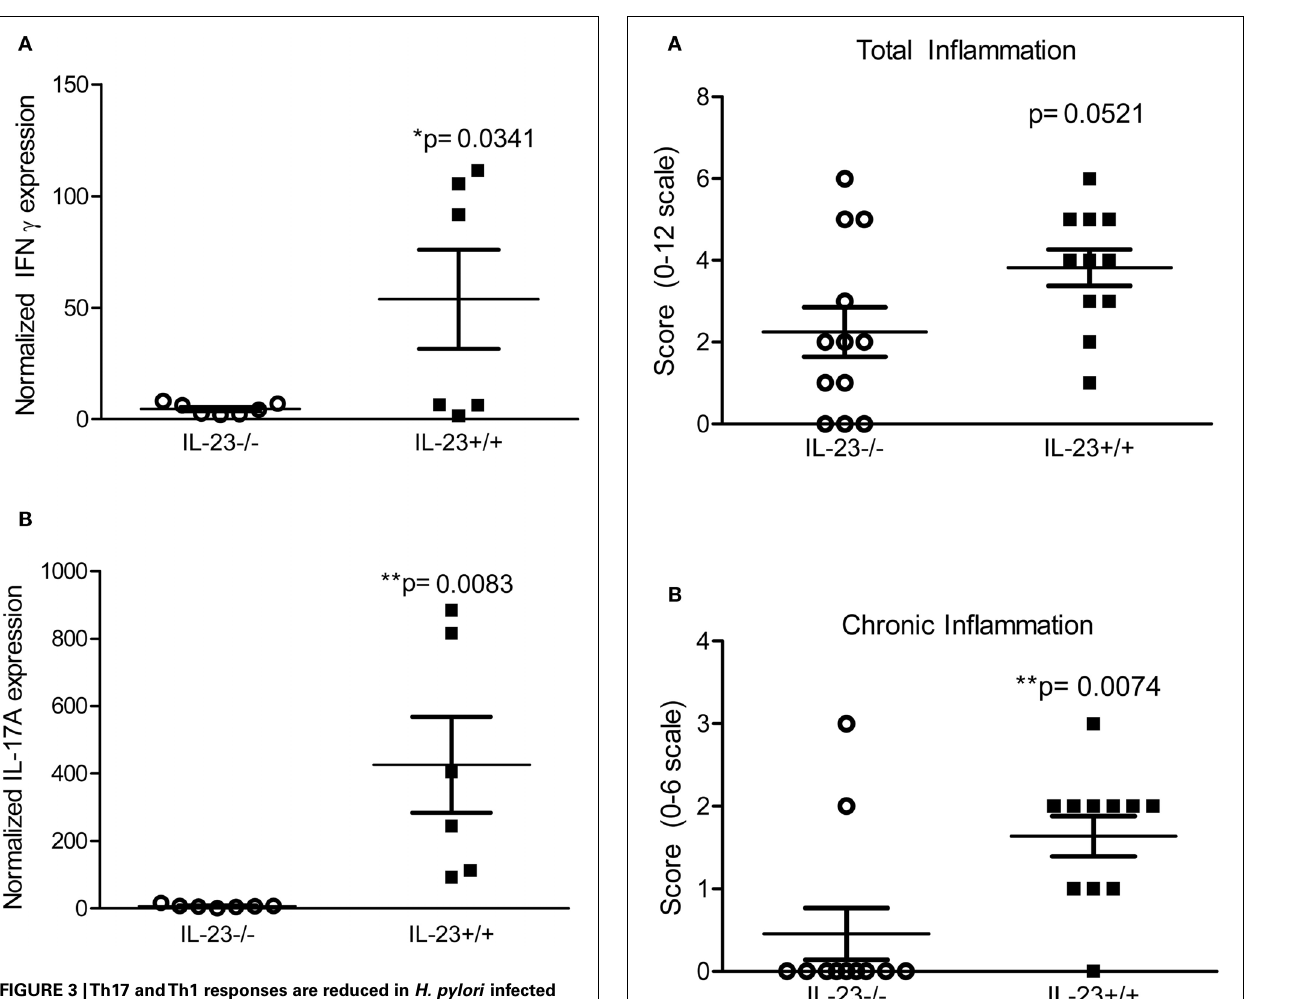
FIGURE 3 |Th17 andTh1 responses are reduced in H. pylori infected IL-23 − / − mice compared to H. pylori infected IL-23 + / + mice. Real time rtPCR was performed on stomach tissue of H. pylori infected mice. Relative units of IFN γ (A) and IL-17A (B) were measured at 3months post-infection. Graphs are representative of three independent experiments.